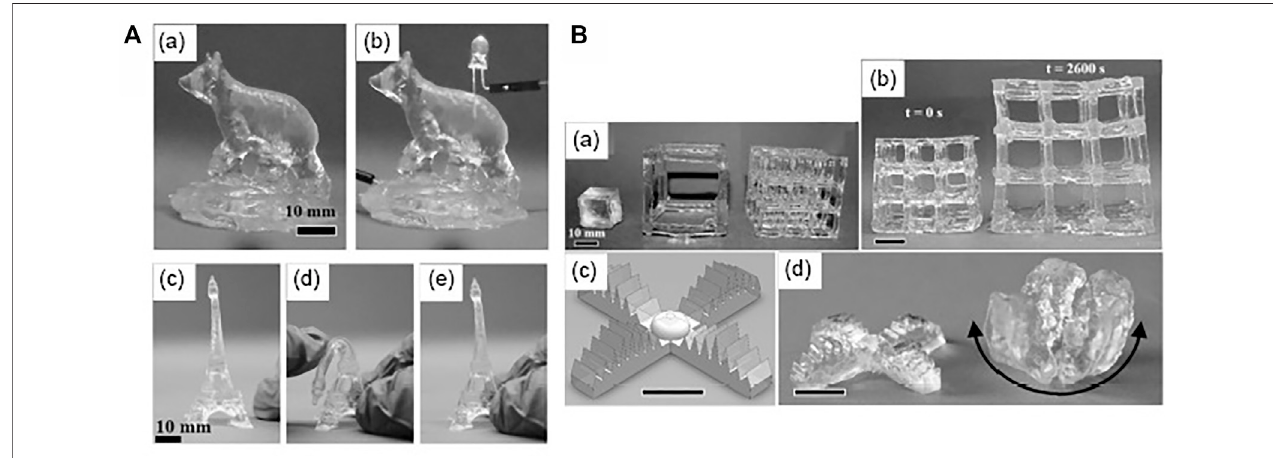
FIGURE 7 | 3D printed hydrogel-based soft, conductive, elastic, and translucent composite structure. (A) (a,b) 3D printed conductive and translucent ionic composite hydrogel (c – e) Illustration of a 3D printed robust Eiffel tower with repeatable distortion. (B) (a-b) 3D printed ionic composite hydrogel structure of different aspect ratios with various shrinking/swelling phenomena with before and after water absorption. (c, d) Design of 3D printed multi-armed hydrogel-based gripper with swelling/shrinking in blue-dyed water (Cvetkovic et al., 2014). Copyright 2017, John Wiley & Sons Inc.